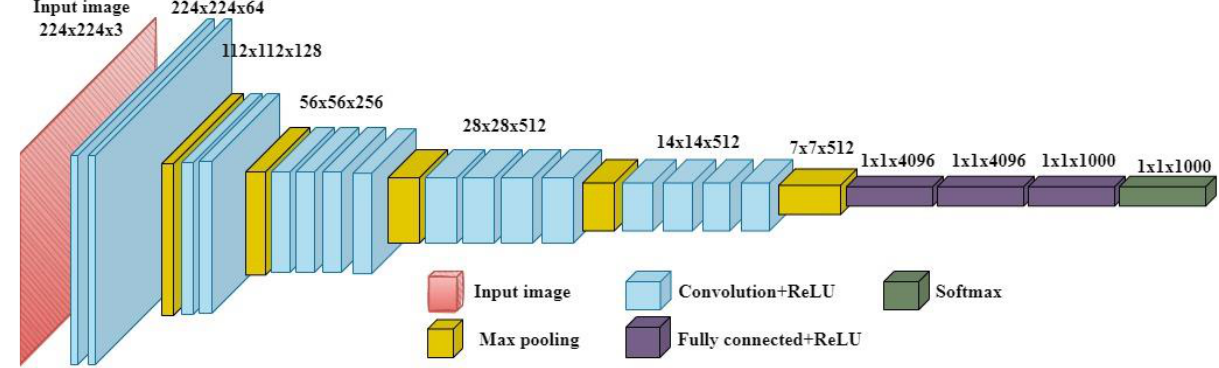
Figure 2. Representation of the VGG-19 architecture used in this research.